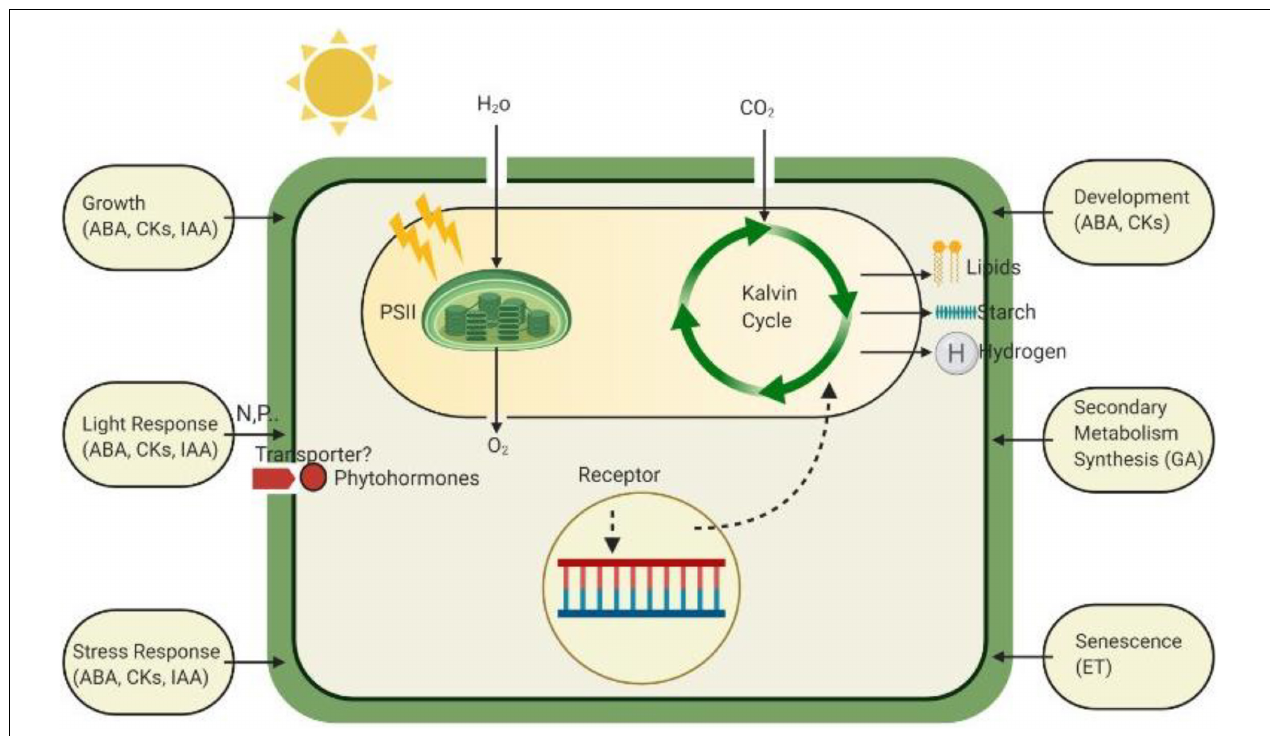
FIGURE 2 | The role of various phytohormones in plants to defend against different stressed conditions by increasing or decreasing their levels. Unstable levels of these hormones work within the defense mechanism of plants to ensure healthy normal growth.